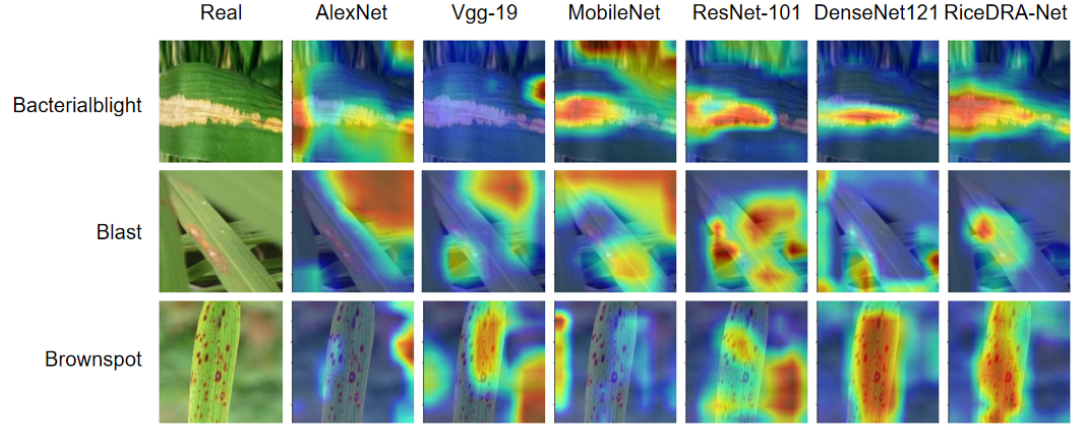
Figure 16. Heat map of disease pictures.